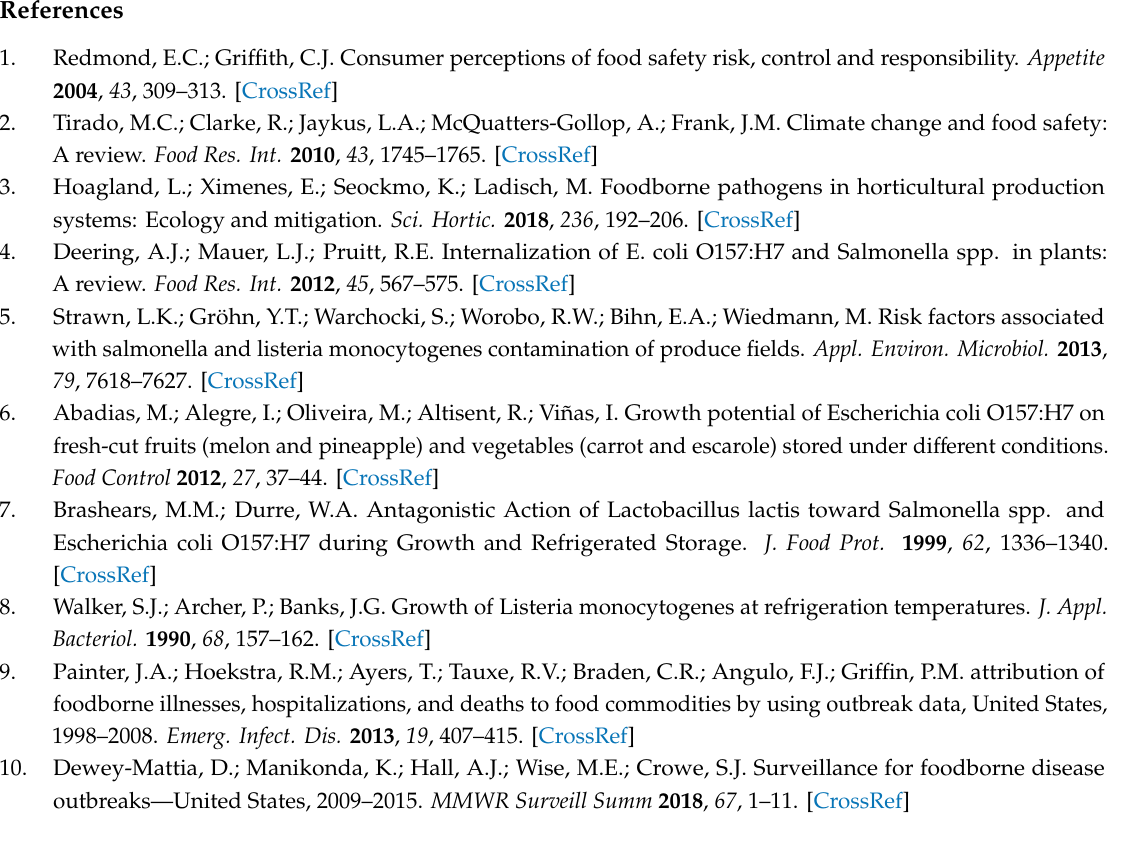
Figure S1: Bacterial isolation using a selective medium for E. coli O157 by plating on CT-SMAC agar with supplement. The red colonies on the plate are presumptive positive E. coli O157. A total of 10 colonies from each sample were confirmed for the presence of stx1 gene using colony PCR., Figure S2: Colony PCR of selected colonies of (A) STEC in aquaponics and (B) STEC in hydroponics. M: 100bp Marker, P: Positive control ( E. coil